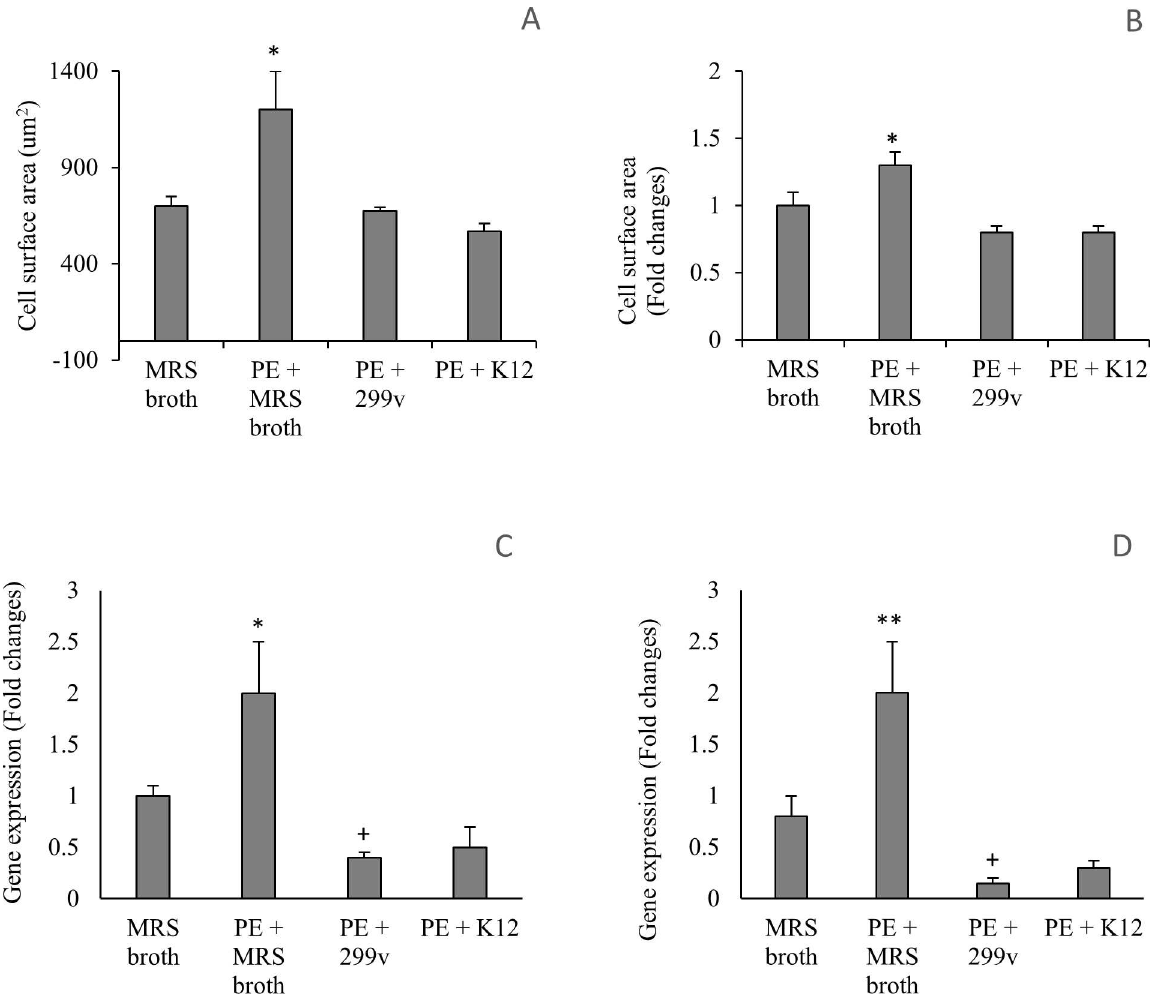
Fig 3. L . plantarum 299v and S salivarius K12 inhibits PE-induced hypertrophy in NVCM. A : The NVCM surface area following 24 hour co-culture with 299v and K12 (n = 5). B : The fold changein NVCM surface area comparedto untreated cells, following24 hour co-culture with 299v and K12 (n = 5). C, D : The fold changein gene expressionof ANP (C) and aSKA (D) comparedto untreated NVCM after 24 hour co-culture with 299v and K12 (n = 3). All volumes of 299v and K12 treatments were 50 μ L (1 x 10 9 CFU/mL stock culture). * P < 0.05 and ** P < 0.01 comparedto all other treatments. + P < 0.05 comparedto MRS broth. Error bars indicatethe